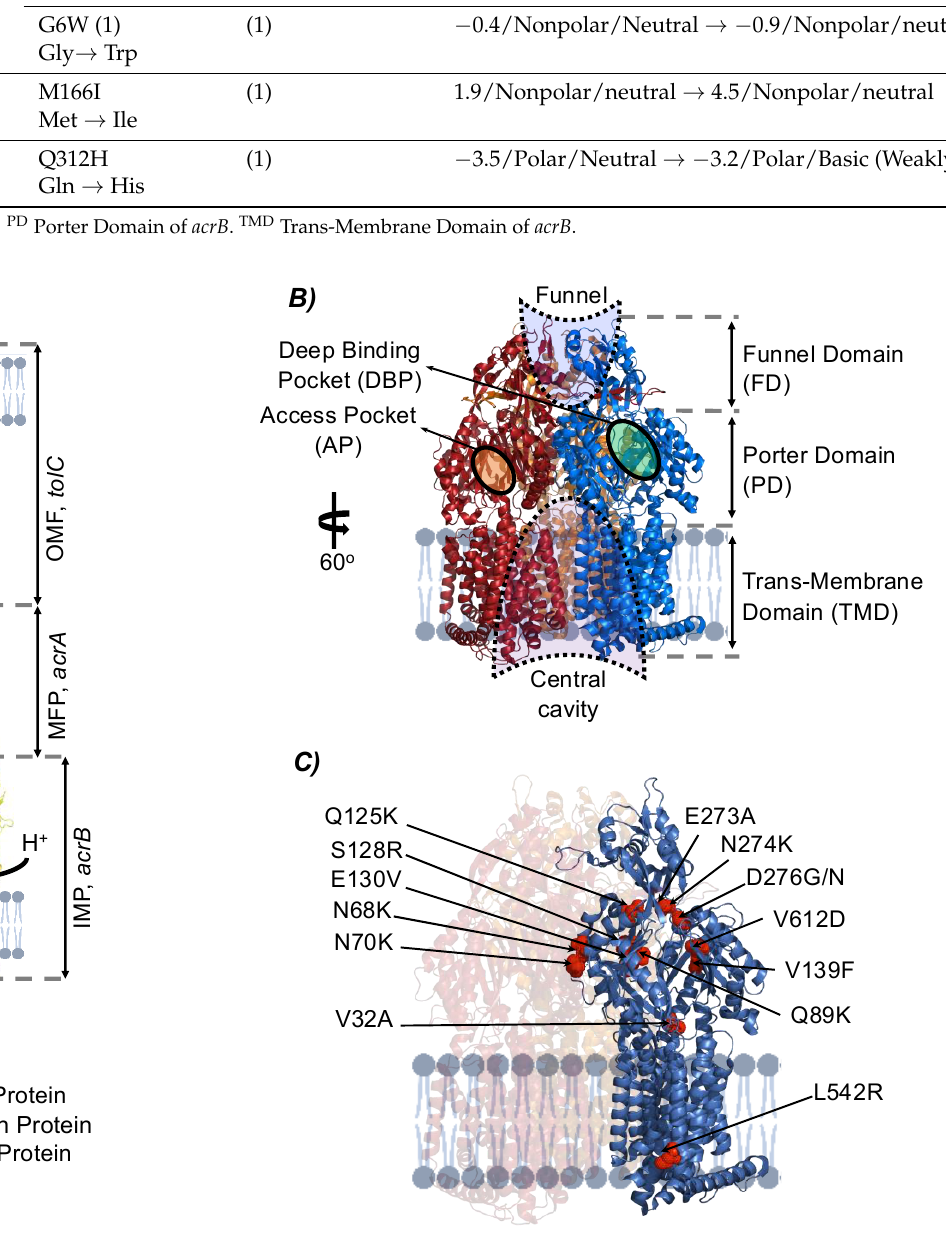
Figure 5. Overview of identified mutations affecting acrB . ( A ) The acrAB/tolC multidrug efflux pump complex (PDB: 5v5s). The complex consists of a resistance-nodulation-division (RND) family inner membrane transporter acrB , a membrane fusion protein (MFP) acrA, and a multifunctional outer membrane channel tolC . The complex is a major contributor to intrinsic resistance for many com- pounds (antibiotics, antiseptics, detergents, dyes, and others) and the transport process is proton dependent. ( B ) The architecture of acrB inner membrane protein (PDB: 4DX5). Depicted is the acrB homotrimer showing the three main domains, namely, a funnel (FD), a porter (PD), and a trans- membrane domain (TMD). The PD of each monomer has two binding pockets, access pocket (AP) and deep binding pocket (DBP). Generally, the transport cycle of a molecule starts with binding to the AP, tunneling to the DBP, and extrusion through a funnel like structure toward tolC via acrA. This transport cycle is aided with a synchronous confirmational changes in the TMD due to a proton release to the cytoplasm. Some compounds might also enter the central cavity via the vestibules between the protomer interfaces at the level of the membrane plane. ( C ) Mutational changes in the acrB. Highlighted is a monomer (blue) with all amino acid substitutions (red) reported in eMRef and eM Δ emrE evolved mutants. All mutations (replicates represented once) were located in the PD and possibly affect the DBP except only one mutation that was found in the TMD. Panels ( A , B ) are adapted from [59]. The MATE (Multidrug And Toxic Compound Extrusion) family protein mdtK is an inner membrane, proton (or sodium) dependent, drug efflux pump within the Multi- drug/Oligosaccharidyl-lipid/Polysaccharide (MOP) flippase superfamily [52,66]. Struc- tural mutations in mdtK were shared among many strains and conditions including eTRef , eMRef , eT Δ emrE , eM Δ emrE , eT Δ tolC , and eM Δ acrB evolutions (Table 2 and Figure 4). In